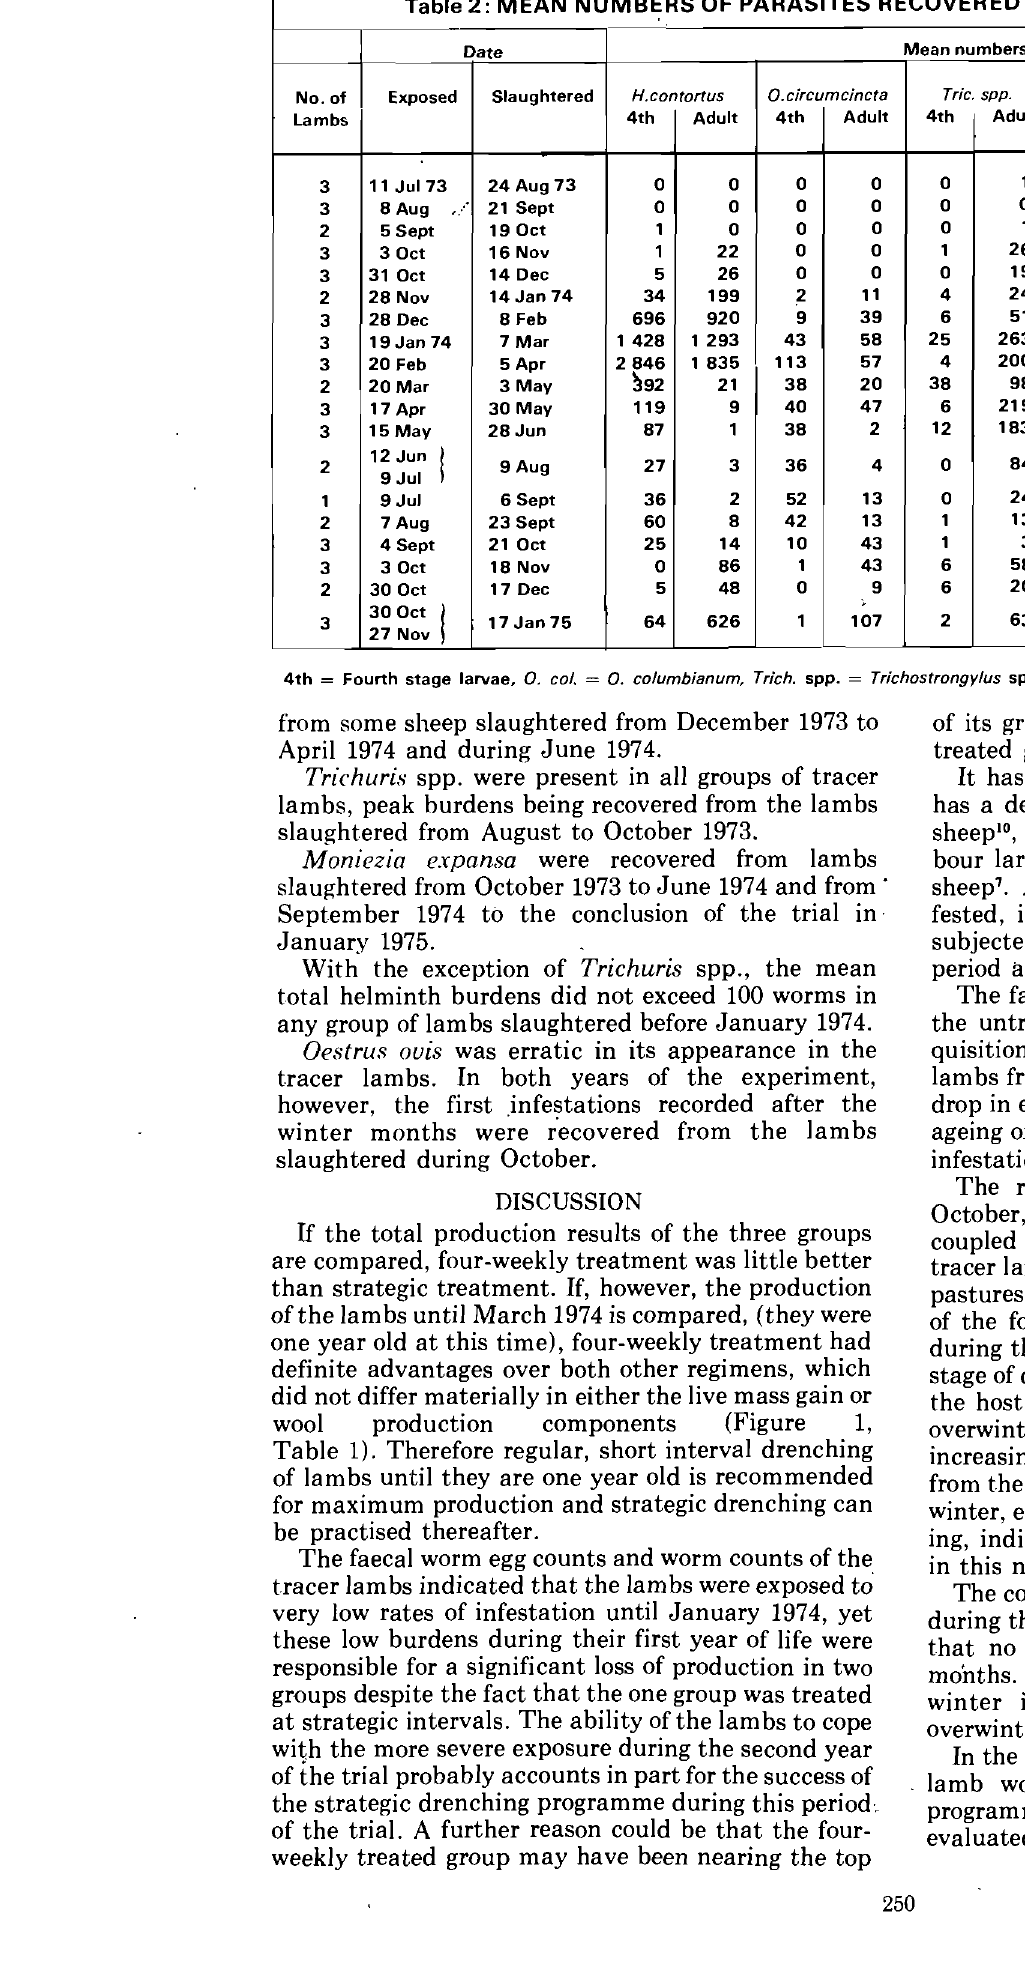
Table 2: MEAN NUMBERS OF PARASITES RECOVERED FROM THE TRACER LAMBS